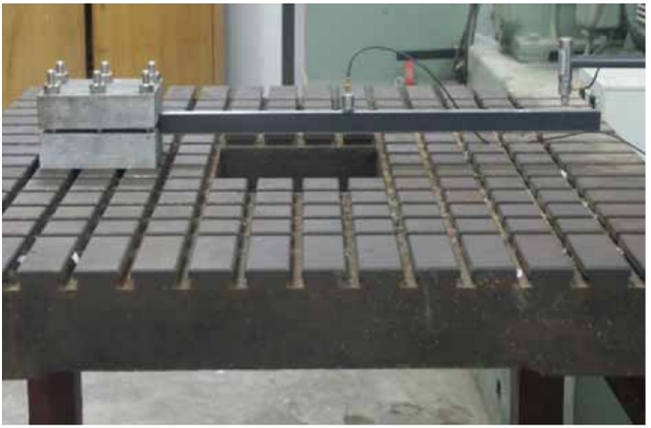
Figure 13. Variation trend of the second harmonic amplitude with signal-to-noise ratio (SNR).